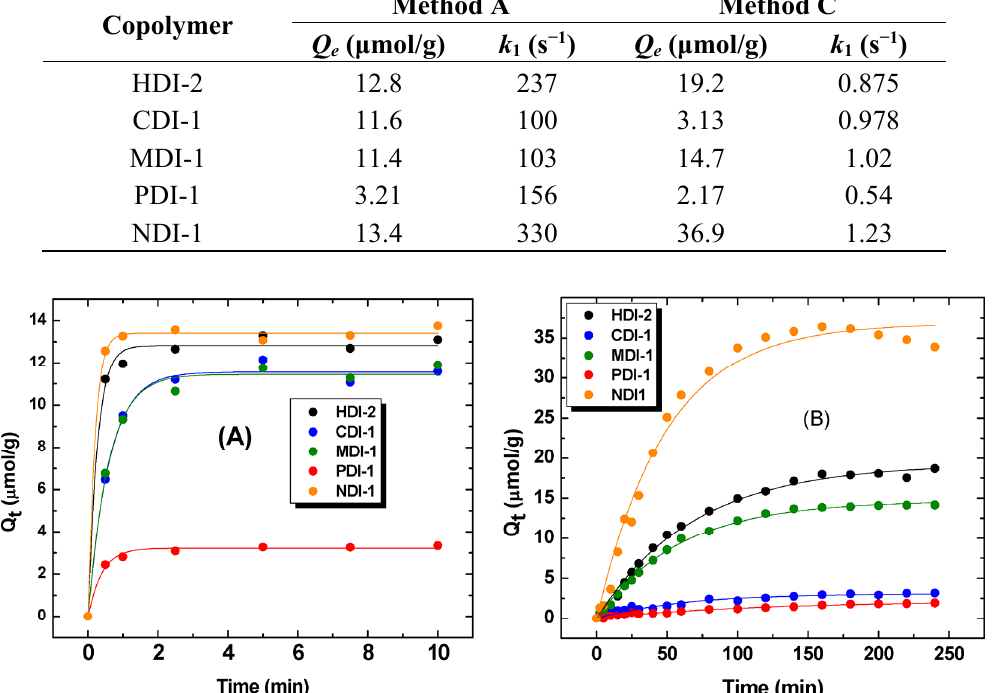
Figure 2. Kinetic uptake isotherms for polyurethane materials (PUs) with phth at pH 10.5 and 25 °C for; ( A ) Method A, and ( B ) Method C. The solid lines represent the “best-fit” using the pseudo-first order (PFO) kinetic